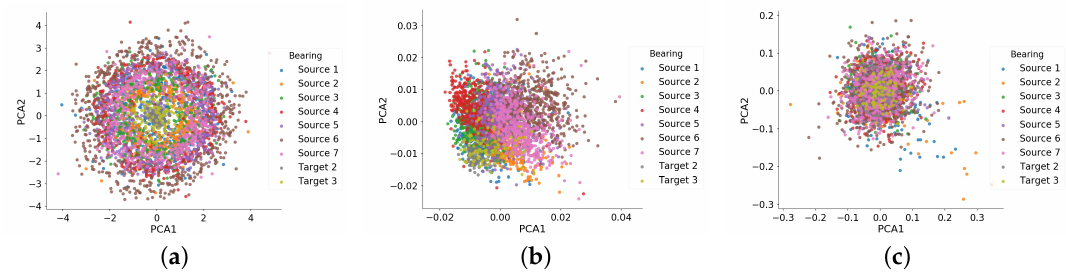
Figure 11. Feature distribution of nine training bearings with ( a ) raw time signal, ( b ) HHT marginal spectrum, and ( c ) the common features extracted by domain adaptation